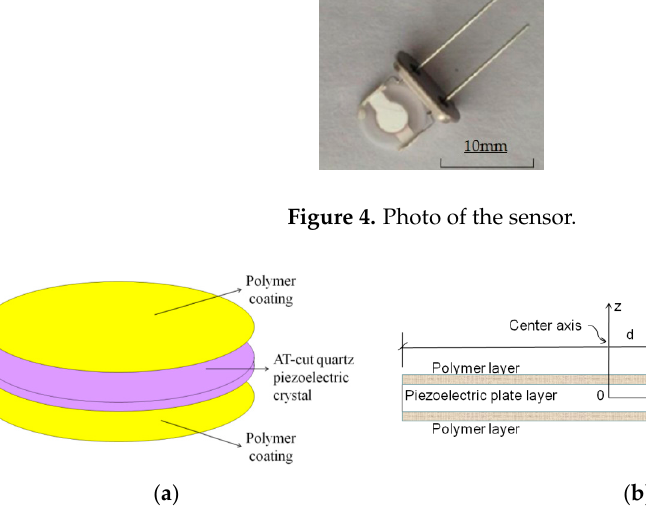
Figure 5. Image of the sensor’s construction. ( a ) Assembly diagram of the sensor’s construction; ( b ) Cross-section drawn of the sensor’s construction.